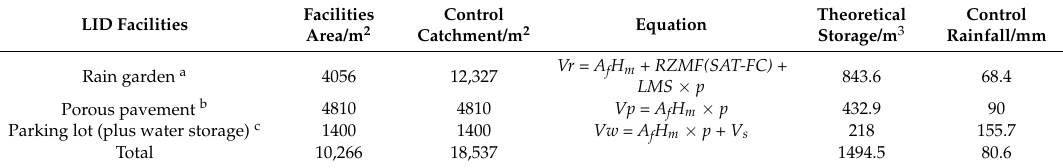
Table 3. Theoretical storage capacity of LID system at a residential drainage unit